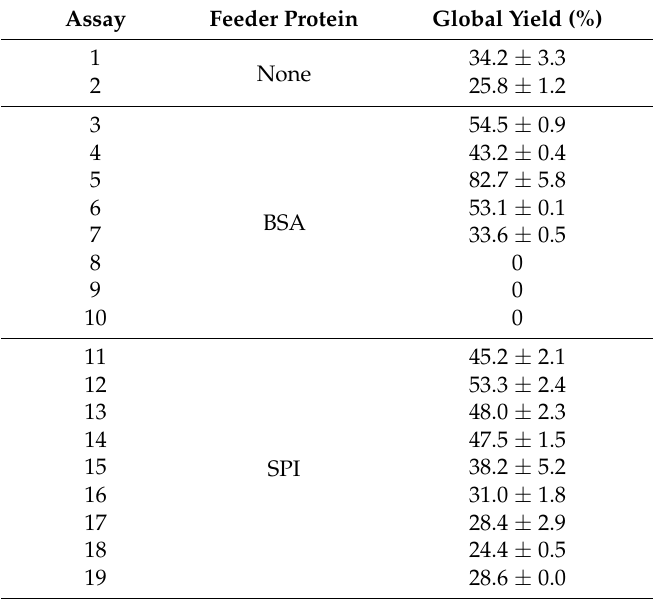
Table 2. Global yields for CLEAs of β -amylase prepared with different concentrations of feeder protein and glutaraldehyde. Assay Feeder Protein Global Yield (%) 1 34.2 ± 3.3 None 2 25.8 ±